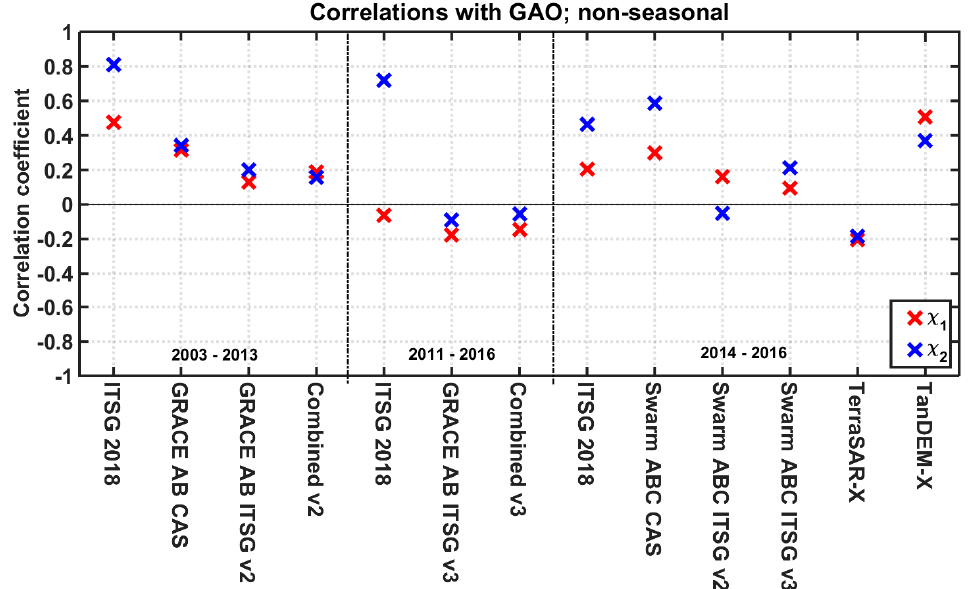
Figure 6. Correlation coefficients between non-seasonal changes of GAO and HAM obtained from ITSG 2018 GRACE solution (ll-SST) and solutions based on kinematic orbits of satellites (hl-SST). Because of the different data lengths of the series, we considered three periods: 2003–2013, 2011–2016, and 2013–2016. The critical values of correlation coefficient are equal to: 0.31 for 2003–2013, 0.37 for 2011–2016, and 0.50 for 2014–2016.